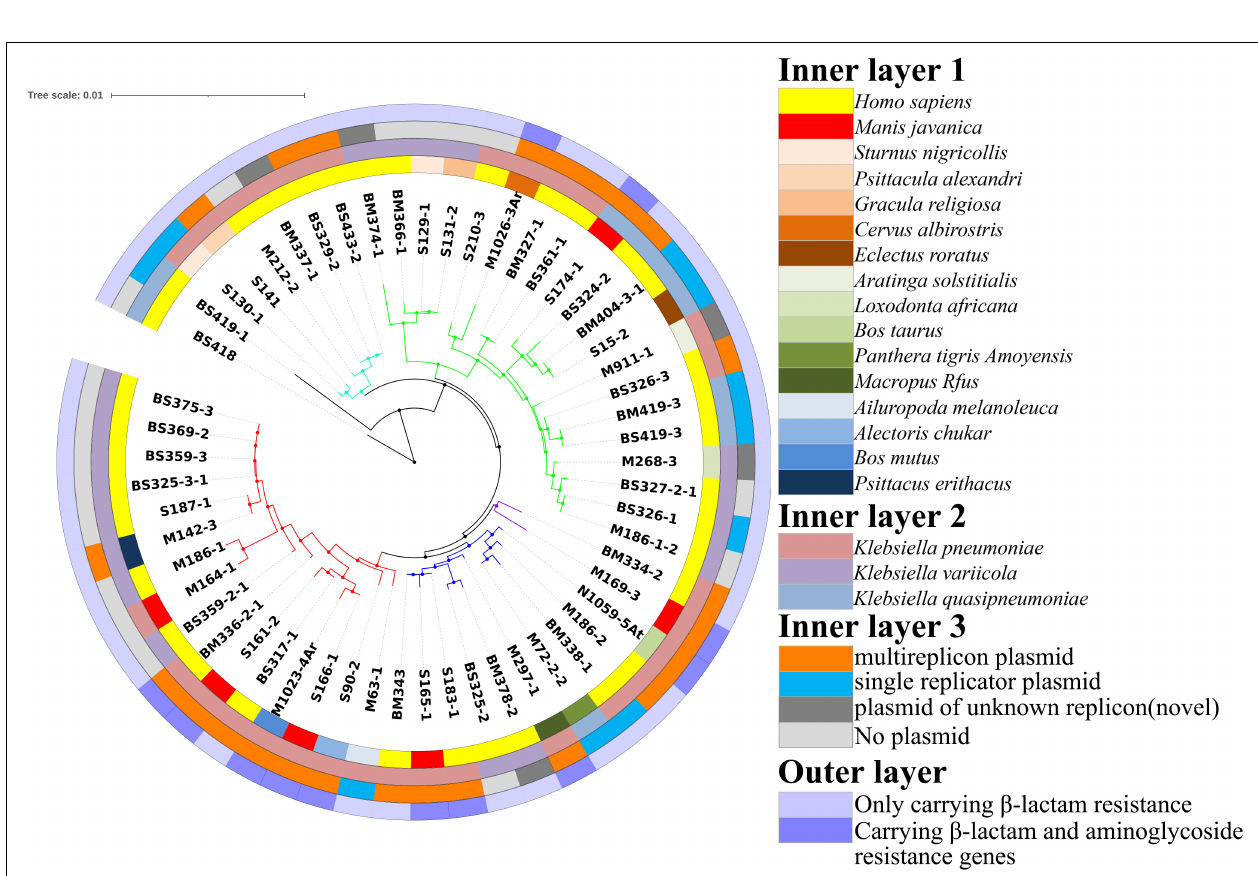
FIGURE 3 | Construction of a phylogenetic tree based on 16S rRNA sequences. Inner layer 1: isolation source; inner layer 2: species; inner layer 3: isolates carrying plasmids; outer layer: plasmids carrying β -lactam resistance genes and aminoglycoside resistance genes.